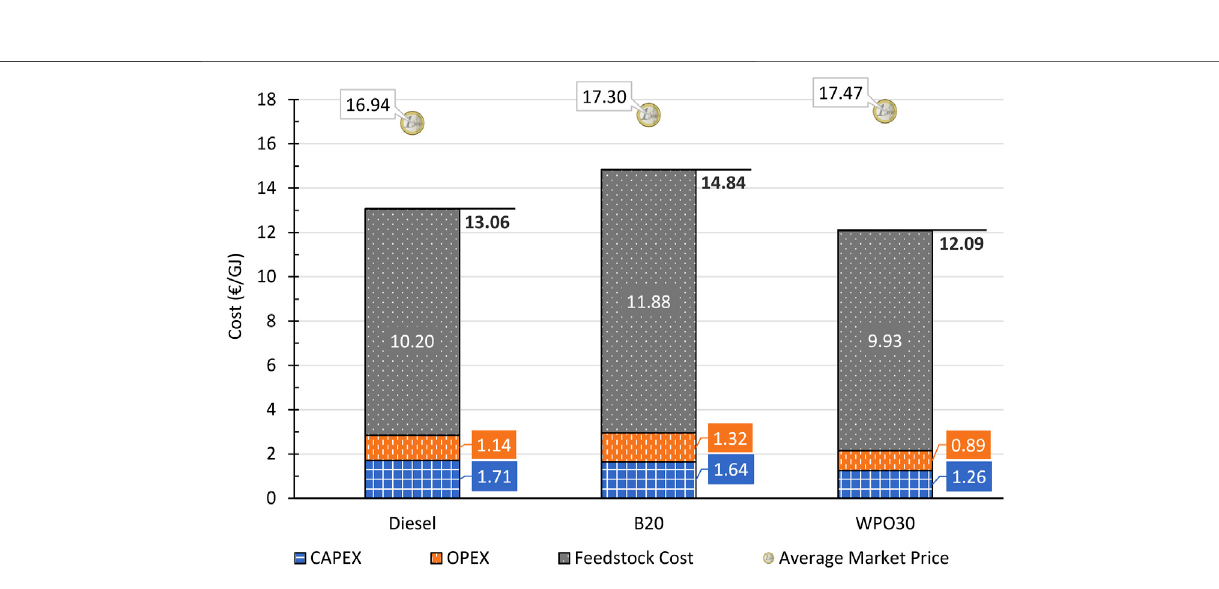
Frontiers in Energy Research |